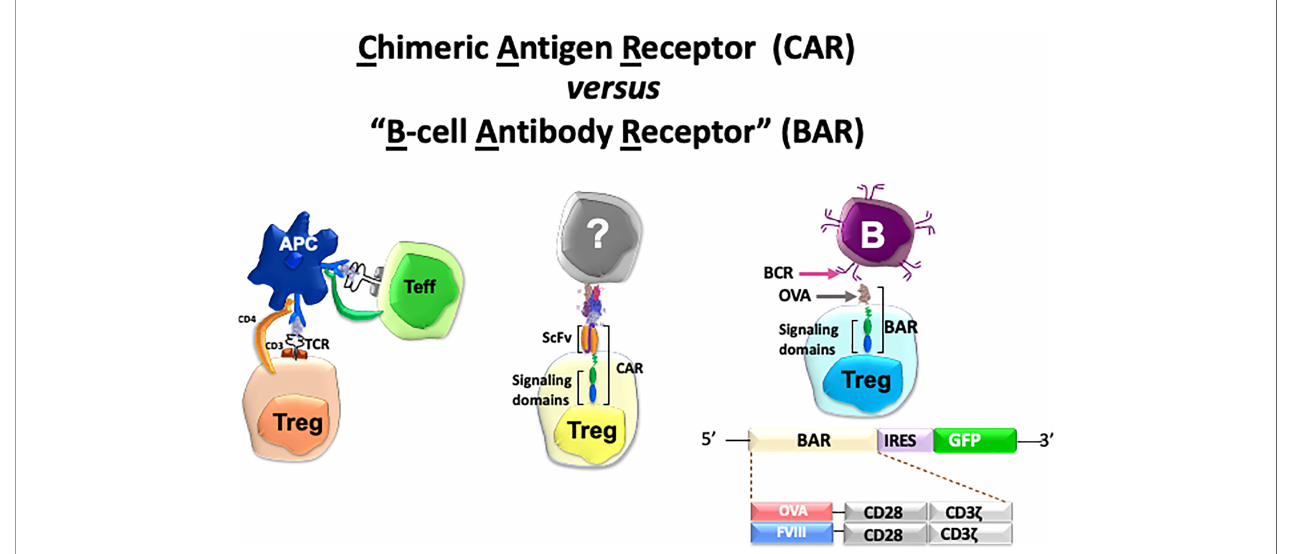
FIGURE 1 | Cartoon of three types of speci fi c Tregs and potential targets used in our lab. See Table 1 for